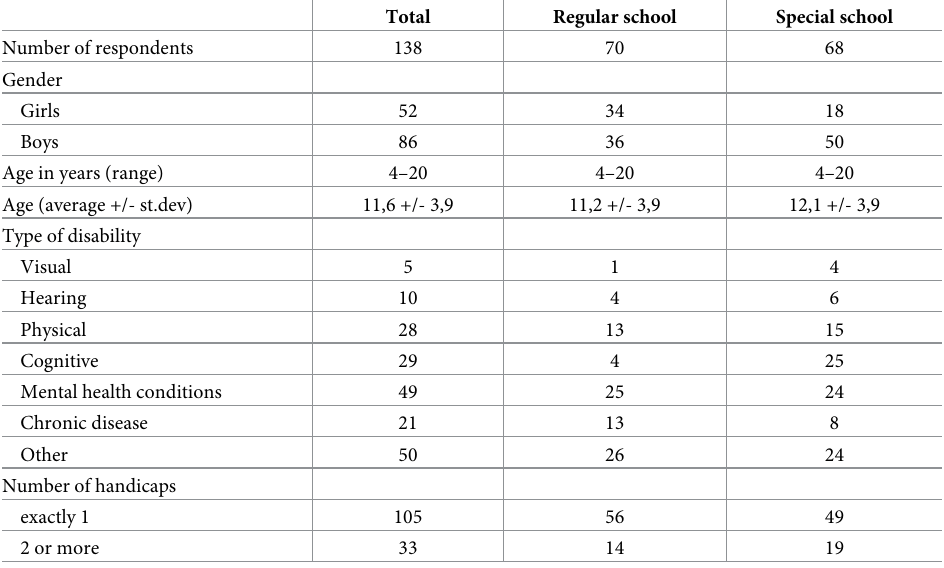
Table 1. Characteristics of the SEN students by school